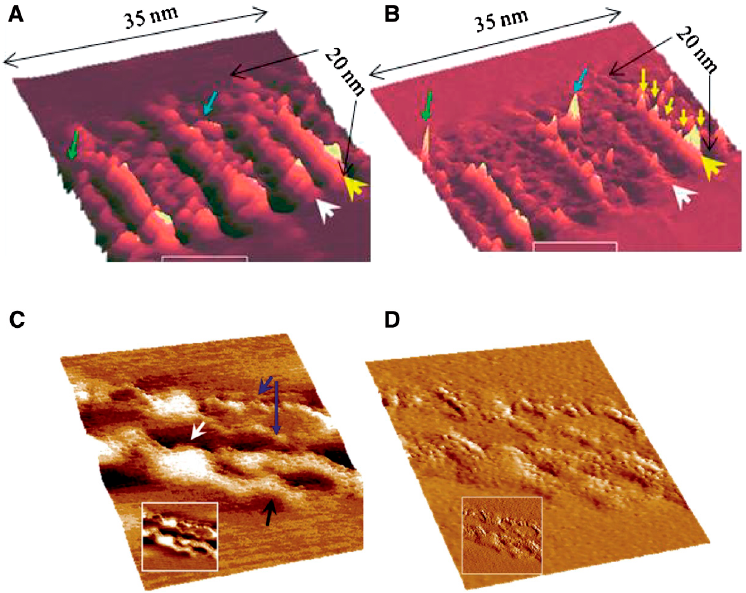
Figure 4. The STM images of the Te-modified DNA duplex (5 ′ -ATGG(TeT)-GCTC-3 ′ and 5 ′ -(GAGCACCAT)6-3’) and its counterpart native duplex on HOPG. The arrows indicate the edges or current peaks of the measured molecules. ( A ) Topographic image of Te-duplex; ( B ) Current image of Te-duplex; ( C ) Topographic image of the native duplex; ( D ) Current image of the native duplex.